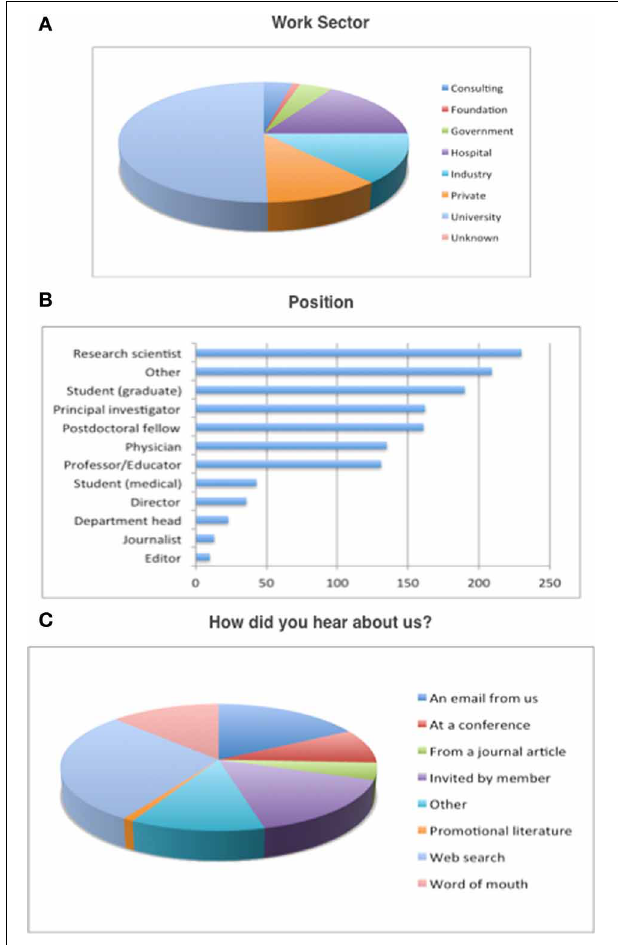
FIGURE 8 | Membership Statistics. (A) Shows the distribution of work sectors, (B) shows the different position of members, and (C) depicts the how different members heard about